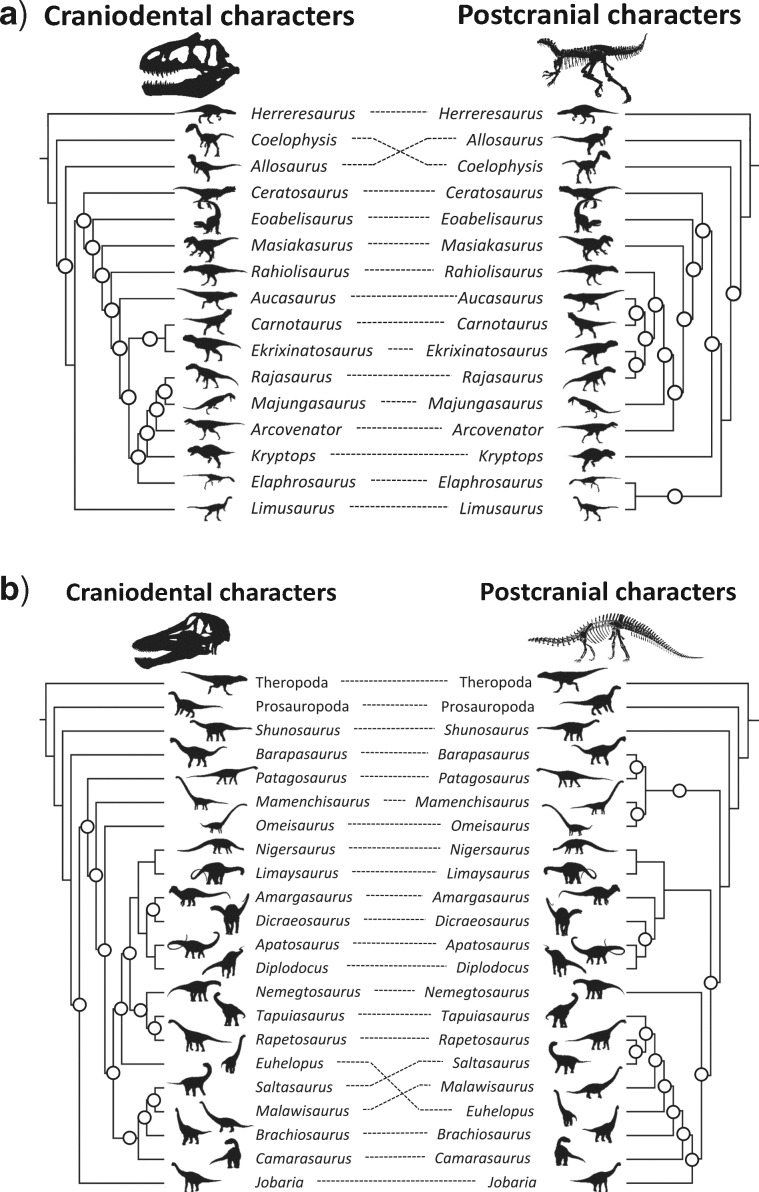
Example tanglegrams for two groups of Saurischia. All trees are majority rule trees, plus compatible groupings. We do not necessarily recommend the use of majority rule trees in calculating IRD statistics (although we summarize these IRD\documentclass[12pt]{minimal}
\usepackage{amsmath}
\usepackage{wasysym} 
\usepackage{amsfonts} 
\usepackage{amssymb} 
\usepackage{amsbsy}
\usepackage{upgreek}
\usepackage{mathrsfs}
\setlength{\oddsidemargin}{-69pt}
\begin{document}
}{}$_{MR}$\end{document} calculations in Tables 1 and 2), because they can be far from the centroid of tree space (Mounce et al. 2016). Rather, we advocate the use of mean distances between nearest neighbors in the two sets of trees for comparison. The left-hand tree in each panel is derived from craniodental characters, while the right-hand tree is derived from postcranial characters. Circled internal nodes are those present in one tree but not the other, and are tallied to give the RF or symmetrical difference distance (Robinson and Foulds 1981). a) Tanglegram for Theropoda using data from Tortosa et al. (2014). (ILD \documentclass[12pt]{minimal}
\usepackage{amsmath}
\usepackage{wasysym} 
\usepackage{amsfonts} 
\usepackage{amssymb} 
\usepackage{amsbsy}
\usepackage{upgreek}
\usepackage{mathrsfs}
\setlength{\oddsidemargin}{-69pt}
\begin{document}
}{}$P=$\end{document} 0.017; IRD\documentclass[12pt]{minimal}
\usepackage{amsmath}
\usepackage{wasysym} 
\usepackage{amsfonts} 
\usepackage{amssymb} 
\usepackage{amsbsy}
\usepackage{upgreek}
\usepackage{mathrsfs}
\setlength{\oddsidemargin}{-69pt}
\begin{document}
}{}$_{NND+RF} P=$\end{document} 0.01; IRD\documentclass[12pt]{minimal}
\usepackage{amsmath}
\usepackage{wasysym} 
\usepackage{amsfonts} 
\usepackage{amssymb} 
\usepackage{amsbsy}
\usepackage{upgreek}
\usepackage{mathrsfs}
\setlength{\oddsidemargin}{-69pt}
\begin{document}
}{}$_{NND+matching} P=$\end{document} 0.01; IRD\documentclass[12pt]{minimal}
\usepackage{amsmath}
\usepackage{wasysym} 
\usepackage{amsfonts} 
\usepackage{amssymb} 
\usepackage{amsbsy}
\usepackage{upgreek}
\usepackage{mathrsfs}
\setlength{\oddsidemargin}{-69pt}
\begin{document}
}{}$_{MR+RF} P=$\end{document} 0.01; IRD\documentclass[12pt]{minimal}
\usepackage{amsmath}
\usepackage{wasysym} 
\usepackage{amsfonts} 
\usepackage{amssymb} 
\usepackage{amsbsy}
\usepackage{upgreek}
\usepackage{mathrsfs}
\setlength{\oddsidemargin}{-69pt}
\begin{document}
}{}$_{MR+matching} P $\end{document}= 0.01). b) Tanglegram for Sauropoda using data from Gorscak et al. (2014). (ILD \documentclass[12pt]{minimal}
\usepackage{amsmath}
\usepackage{wasysym} 
\usepackage{amsfonts} 
\usepackage{amssymb} 
\usepackage{amsbsy}
\usepackage{upgreek}
\usepackage{mathrsfs}
\setlength{\oddsidemargin}{-69pt}
\begin{document}
}{}$P=$\end{document} 0.074; IRD\documentclass[12pt]{minimal}
\usepackage{amsmath}
\usepackage{wasysym} 
\usepackage{amsfonts} 
\usepackage{amssymb} 
\usepackage{amsbsy}
\usepackage{upgreek}
\usepackage{mathrsfs}
\setlength{\oddsidemargin}{-69pt}
\begin{document}
}{}$_{NND+RF} P=$\end{document} 0.02; IRD\documentclass[12pt]{minimal}
\usepackage{amsmath}
\usepackage{wasysym} 
\usepackage{amsfonts} 
\usepackage{amssymb} 
\usepackage{amsbsy}
\usepackage{upgreek}
\usepackage{mathrsfs}
\setlength{\oddsidemargin}{-69pt}
\begin{document}
}{}$_{NND+matching} P=$\end{document} 0.02; IRD\documentclass[12pt]{minimal}
\usepackage{amsmath}
\usepackage{wasysym} 
\usepackage{amsfonts} 
\usepackage{amssymb} 
\usepackage{amsbsy}
\usepackage{upgreek}
\usepackage{mathrsfs}
\setlength{\oddsidemargin}{-69pt}
\begin{document}
}{}$_{MR+RF} P=$\end{document} 0.02; IRD\documentclass[12pt]{minimal}
\usepackage{amsmath}
\usepackage{wasysym} 
\usepackage{amsfonts} 
\usepackage{amssymb} 
\usepackage{amsbsy}
\usepackage{upgreek}
\usepackage{mathrsfs}
\setlength{\oddsidemargin}{-69pt}
\begin{document}
}{}$_{MR+matching} P=$\end{document} 0.01). All silhouettes are original drawings by Yimeng Li.